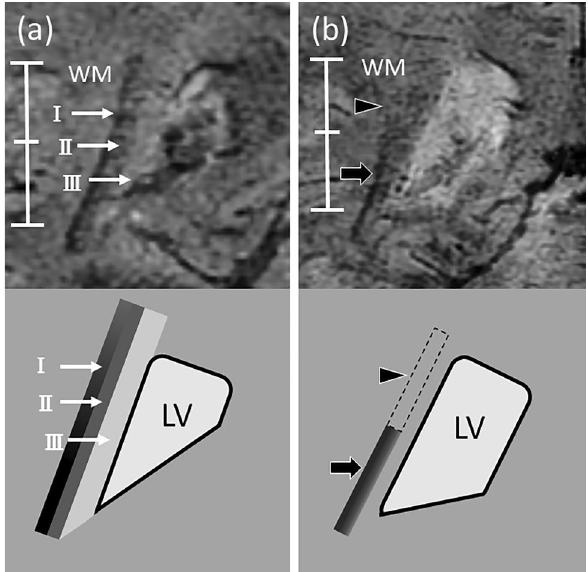
Figure 1. Coronal phase difference-enhanced imaging images from ( a ) healthy subjects and ( b ) patients with dementia with Lewy bodies and visual hallucinations. ( a ) The delineation of three layers at the right optic radiation (OR) (I: external sagittal stratum, II: internal sagittal stratum, and III: tapetum) in a healthy subject (a 62-year-old woman). ( b ) The obscuration of three layers in the OR (black arrowhead) and the disappearance of the cranial side of the OR (black arrow) in a patient with Dementia with Lewy bodies and visual hallucinations (a 69-year-old